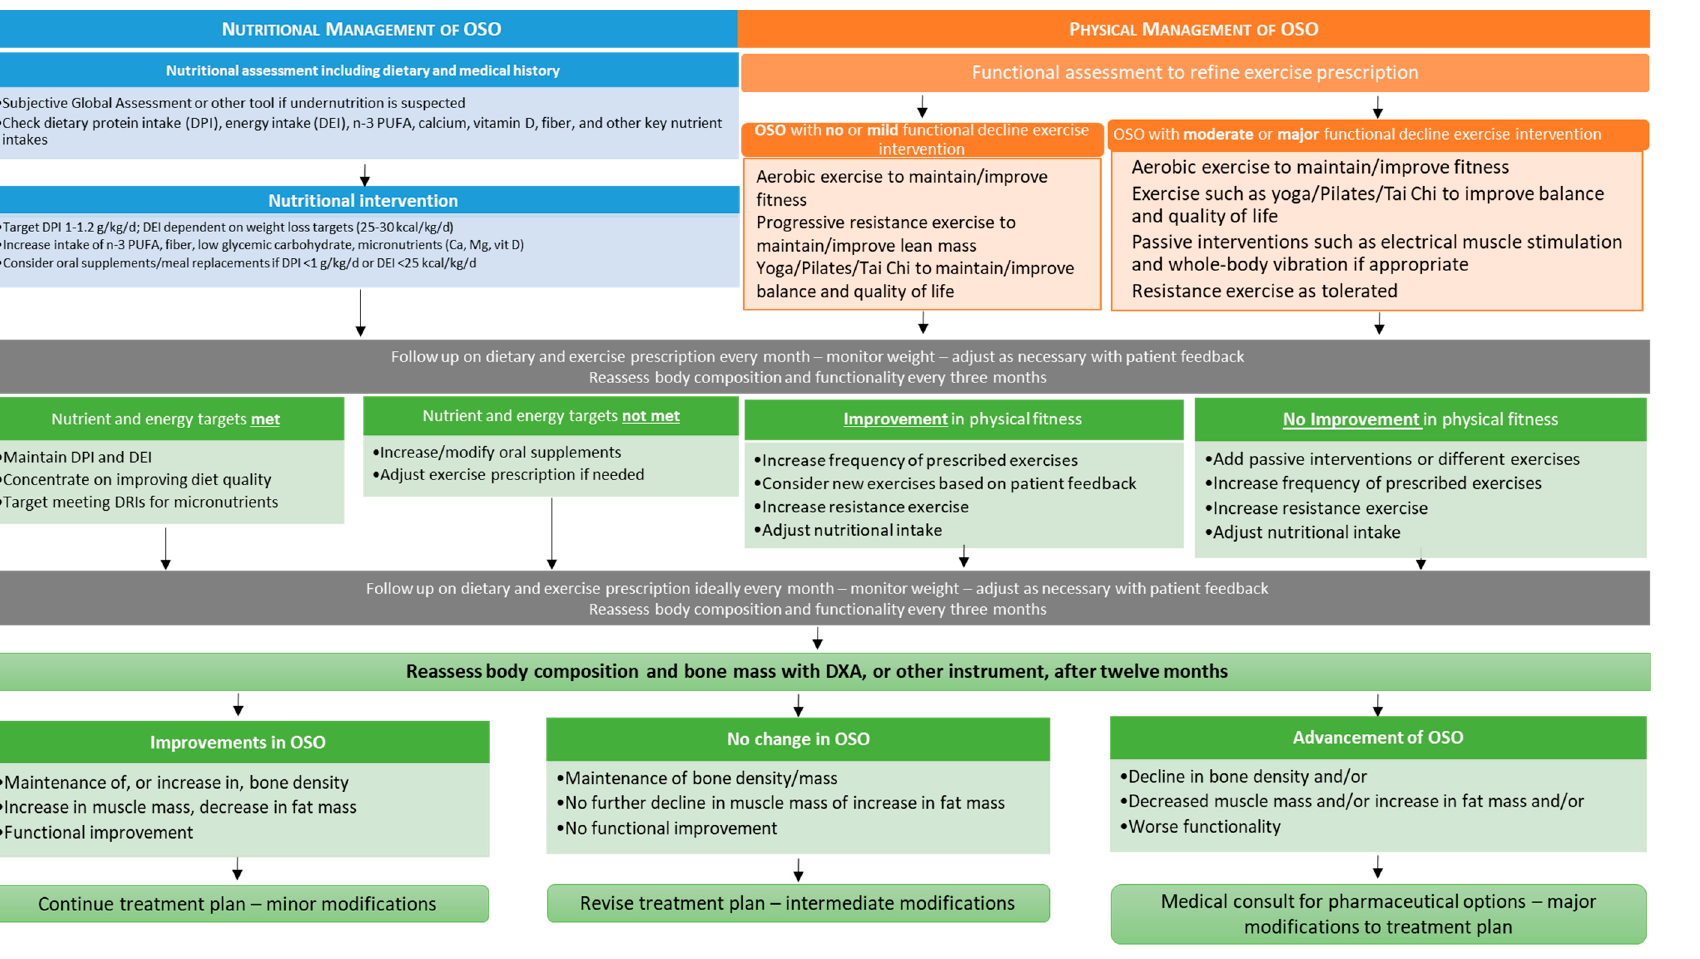
Figure 2. The nutritional and exercise treatment principles for OSO.